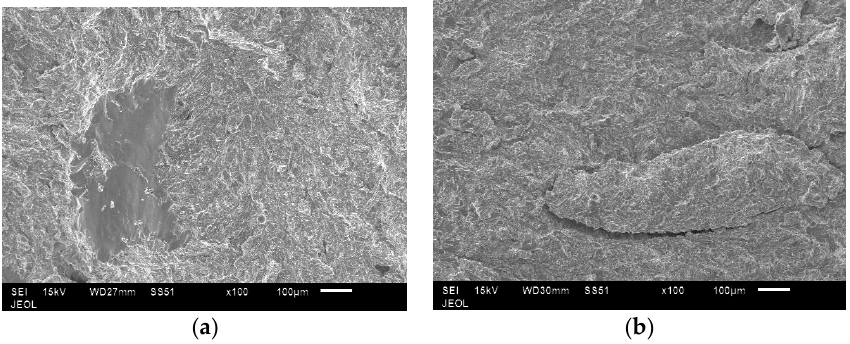
Figure 17. Presence of keyhole defect in high energy sample ( a ) Evidence of shear lip features in medium energy ( b ) Fracture surfaces.